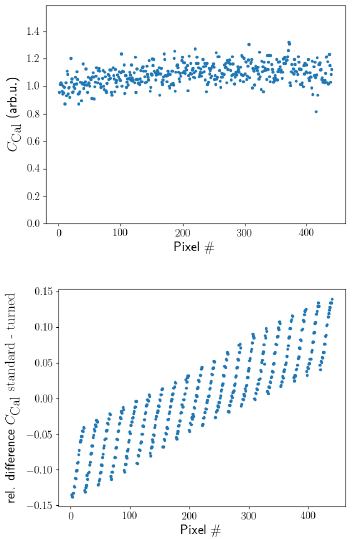
Figure 5. Calibration constants for the 440 pixels of a FD camera in arbitrary units when the sphere is mounted as seen in fig. 2, lower picture (upper plot). A slight increase from the left to the right is visible. When the sphere is rotated by 180 ◦ a left-to-right decrease is expected and the difference between both configurations is shown (lower